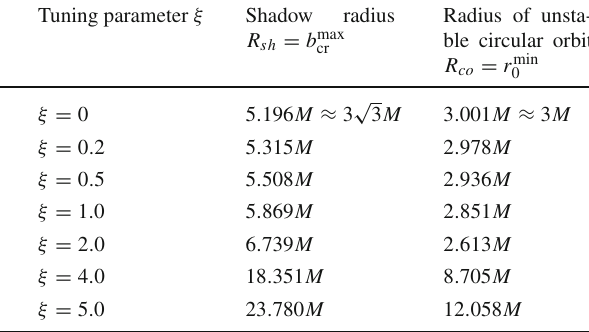
Table 1 Shadow and circular photon orbit for acoustic Schwarzschild black hole. In this table, the radius of black hole shadow and unstable circular orbit are listed for several tuning parameter ξ . The R sh = b max cr is the shadow radius detected by observer located at infinity, and R co = r min isradiusofunstablecircularorbitforacousticSchwarzschildblack 0 hole. As we have explained in Sect.2, when tuning parameter 0 < ξ < 4, only the “optical” horizon r h = 2 M exists. When tuning parameter ξ > 4, the additional interior and exterior “acoustic” event horizons (cid:9) (cid:9) = M (ξ + ξ 2 − 4 ξ) and r ξ 2 − 4 ξ) emerge. r ac − = M (ξ − ac +